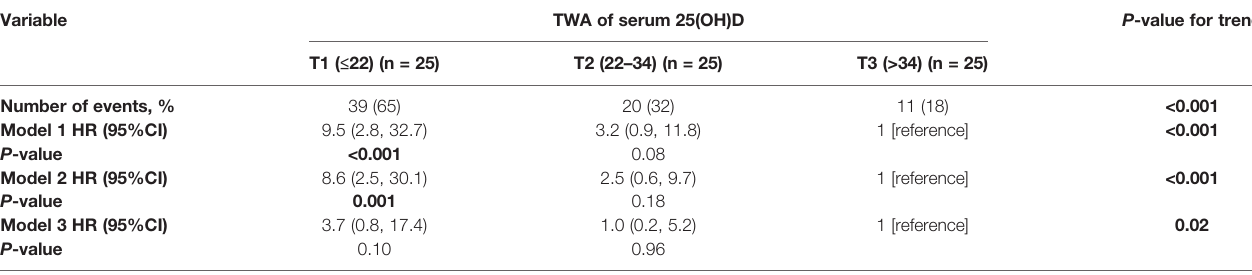
TABLE 6 | Effect of time weighted average of serum 25(OH)D on renal outcomes.